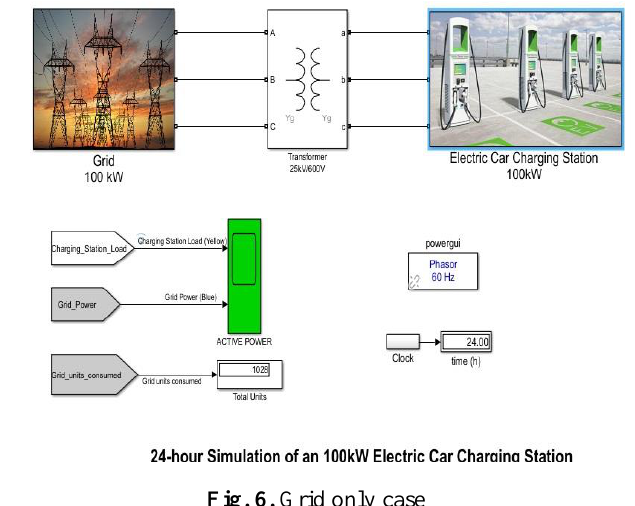
Fig. 9. Results when renewable energy resources start